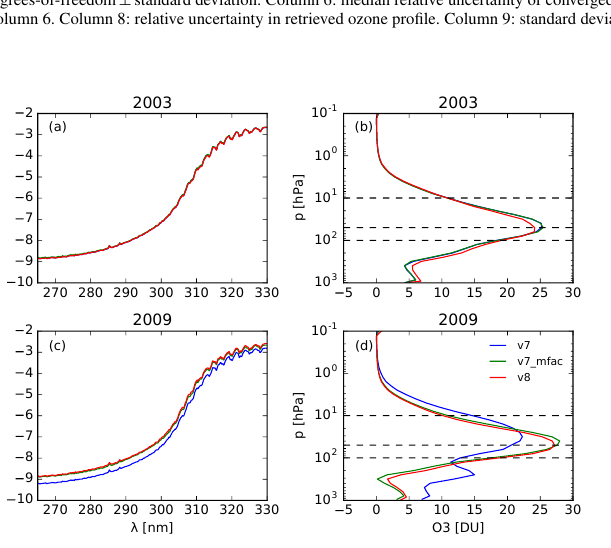
Figure 3. (a) Measured reflectance spectra for the year 2003 in nat- ural log units. The spectra are the medians for all states located close to the ozone sonde stations within the tropical latitude band 10 ◦ N– 10 ◦ S. (b) Corresponding retrieved ozone profiles (in Dobson units per layer) with different colours representing various versions of L1 SCIAMACHY data used. The version 7 with and without degrada- tion correction almost overlap (blue and green lines) whereas ver- sion 8 with improved degradation correction has a visible difference in the ozone profile. Panels (c) and (d) are the corresponding figures of panels (a) and (b) for the year 2009. Note the remarkable differ- ence between v7 and later versions with degradation corrections. Here the later two versions almost overlap compared to the case where no degradation is taken into account. The number of states in each data set with corresponding uncertainties are listed in Table 3. The dashed horizontal lines indicates the pressure levels 10, 50 and 100hPa.